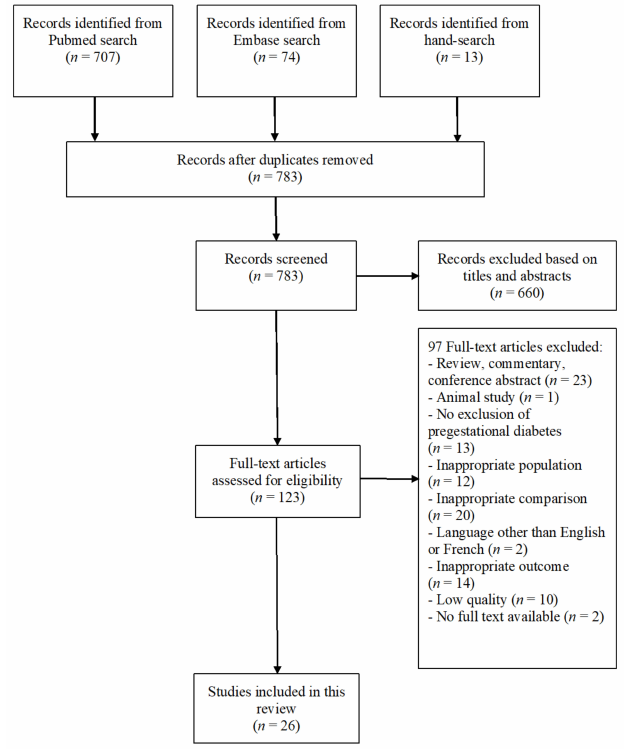
Figure 1. The literature search and selection